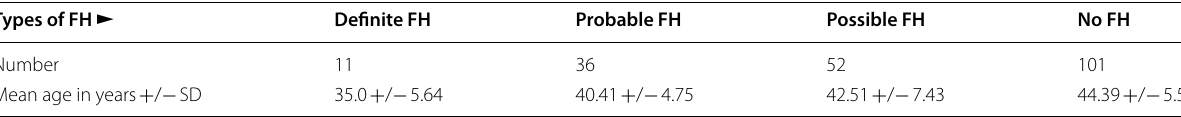
Table 3 Mean age of FH patients Types of FH ►